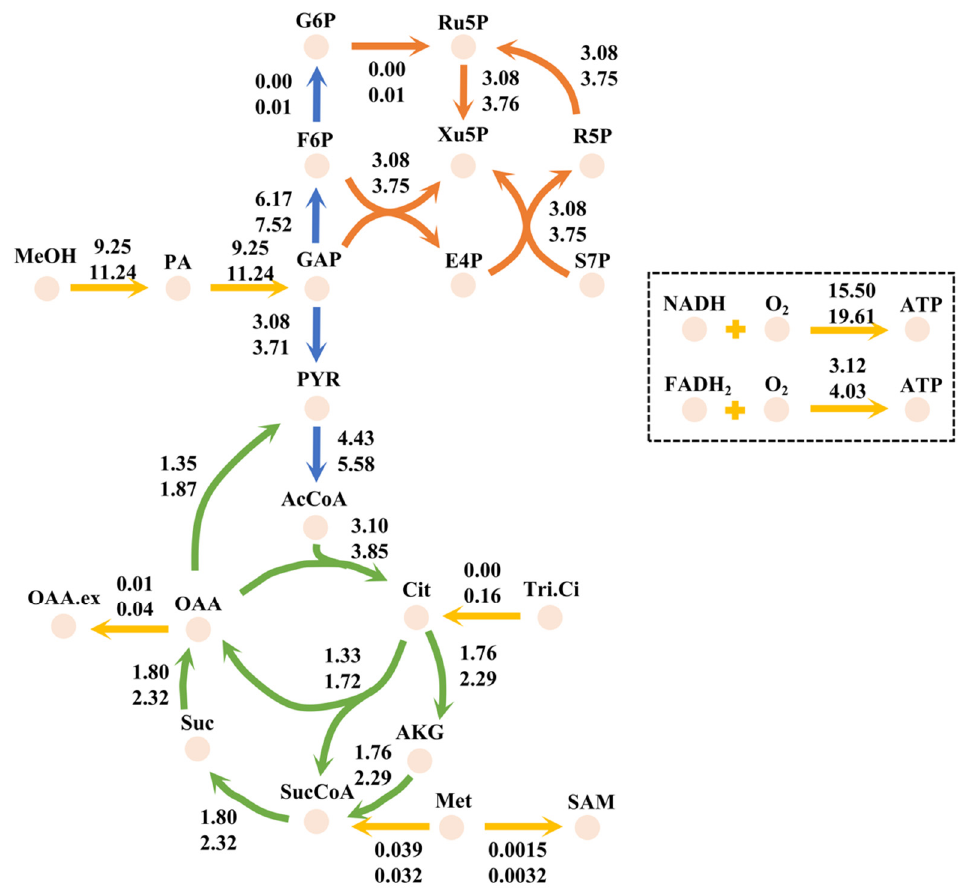
Figure 4. Metabolic flux analysis between control and experimental groups during the induction phase 24–36 h (The numbers near the reaction represent metabolic flux values, mmol/gDCW/h. The upper values are for the control group and the lower values are for the experimental group.). Ab-